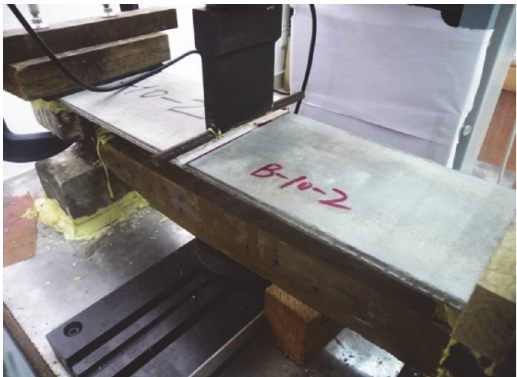
Figure 5: Load-displacement curves of specimens T-B.